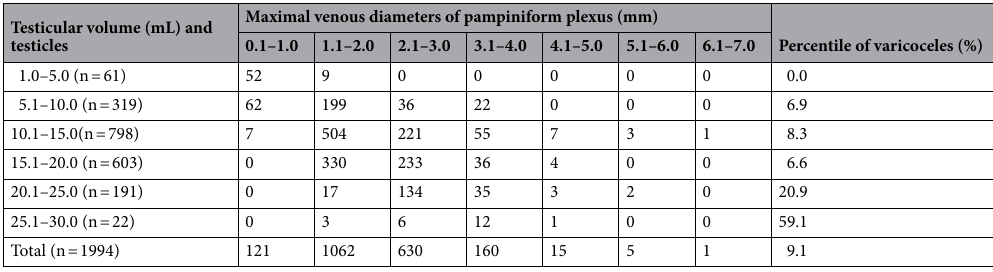
Table 1. Distributions of testicular volumes, maximal venous diameters of pampiniform plexus and percentile of varicoceles.